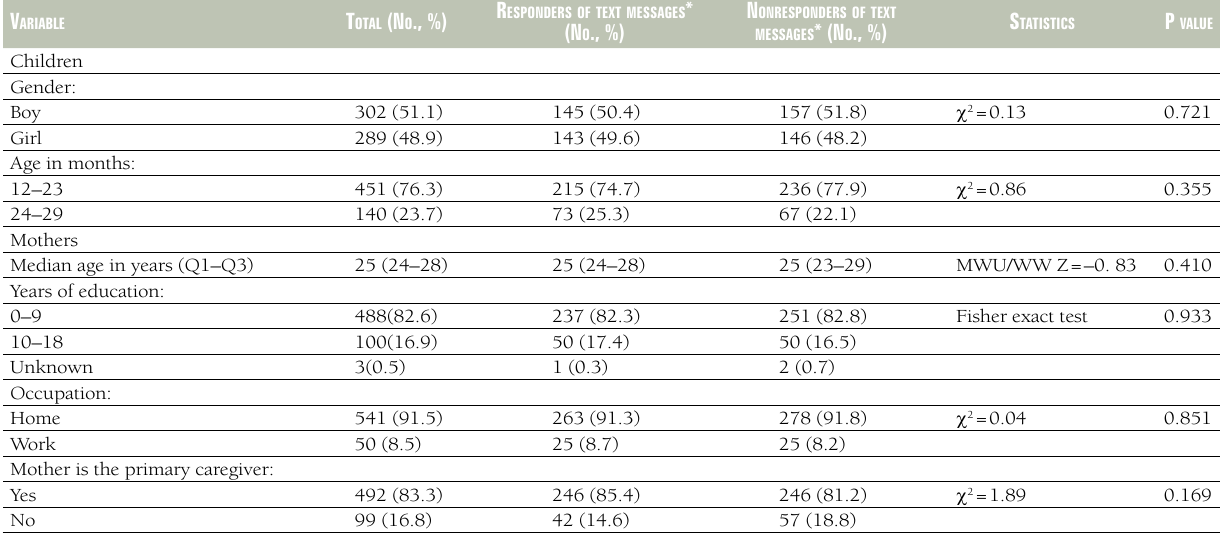
Table 1. Demographic characteristics of children and their mothers V